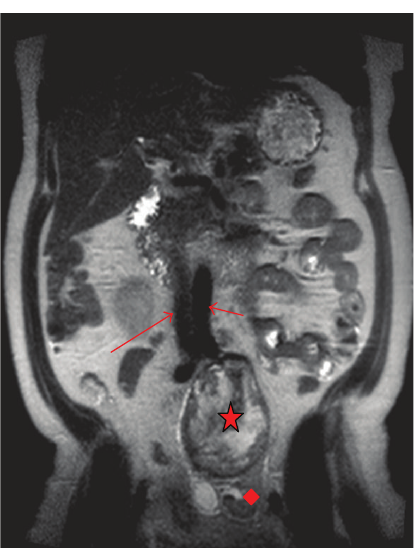
Figure 1: T2-weighted MRI image (coronal view) showing orien- tation of mass (star) to major vessels. Normal kidney (diamond). Aorta (short arrow). IVC (long arrow). Note that aortic bifurcation occurs at level of superior pole of ectopic left kidney.